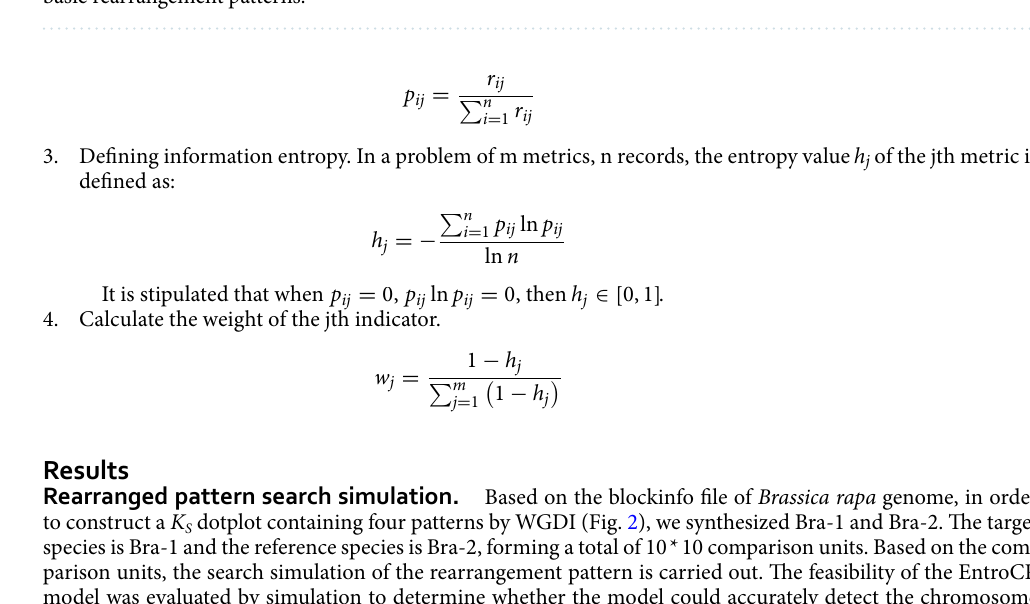
Figure 2. K S dotplot between Bra-1 and Bra-2. The red boxes represent the chromosomes involved in the four basic rearrangement